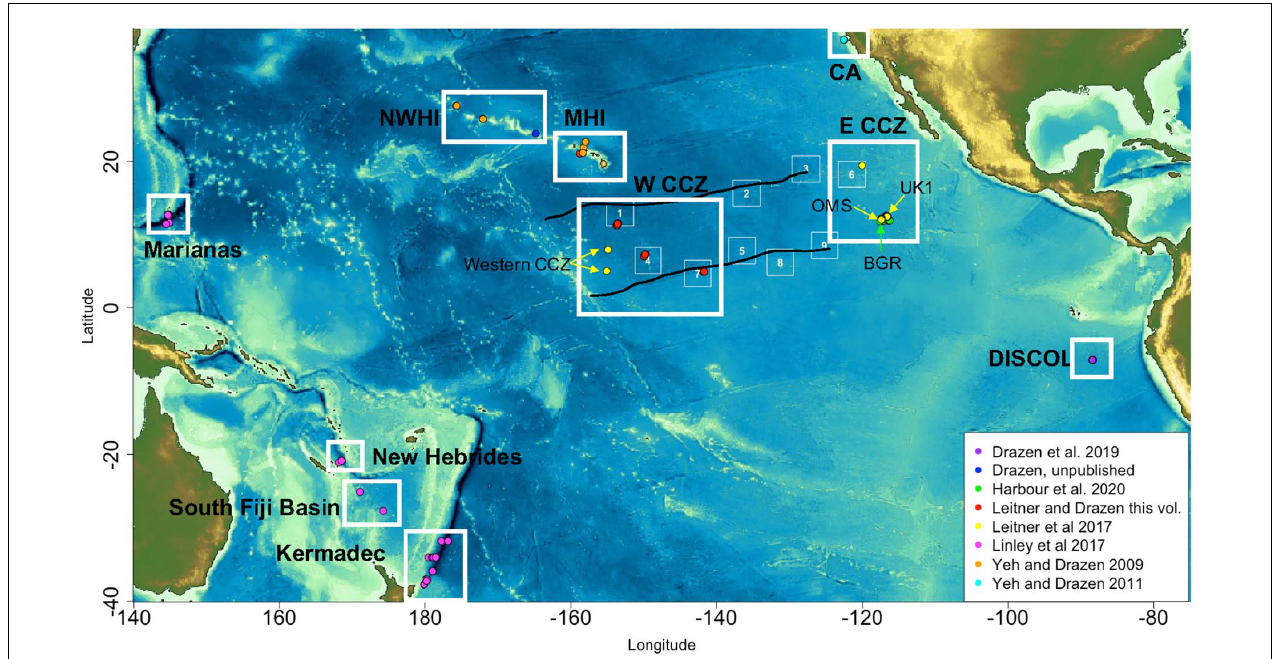
FIGURE 1 | Baited camera sample locations across the Pacific and CCZ region by study. White boxes represent general provinces of sampling.